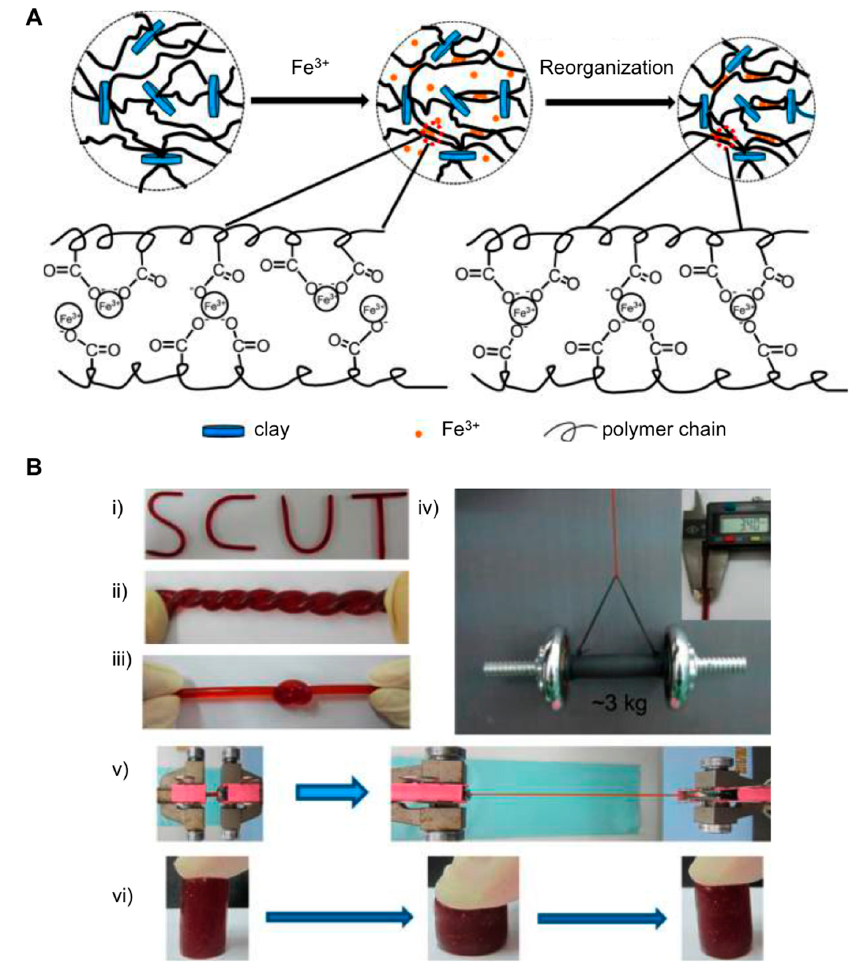
Figure 2. ( A ) Preparation of dual physically cross-linked (DPC) hydrogels: In situ polymerization of AAm and acrylic acid (AAc) in the presence of clay to form physically cross-linked network; the interaction of –COO– groups of polymer chains with Fe 3+ and then reorganization of Fe 3+ coordinates to introduce Fe 3+ coordination physically cross-linked points. ( B ) DPC hydrogel can be ( i ) bended, ( ii ) twisted into double-helix structure, and ( iii ) knotted. ( iv ) DPC hydrogel with the diameter of 3.4 mm lifts up dumbbell of ca. 3 kg in weight. ( v ) High strain is applied to the DPC hydrogel. ( vi ) DPC hydrogel can be strongly compressed and quickly recovered its shape upon the removal of compression force. Adapted with permission from Reference [40]. Copyright 2016 American Chemical